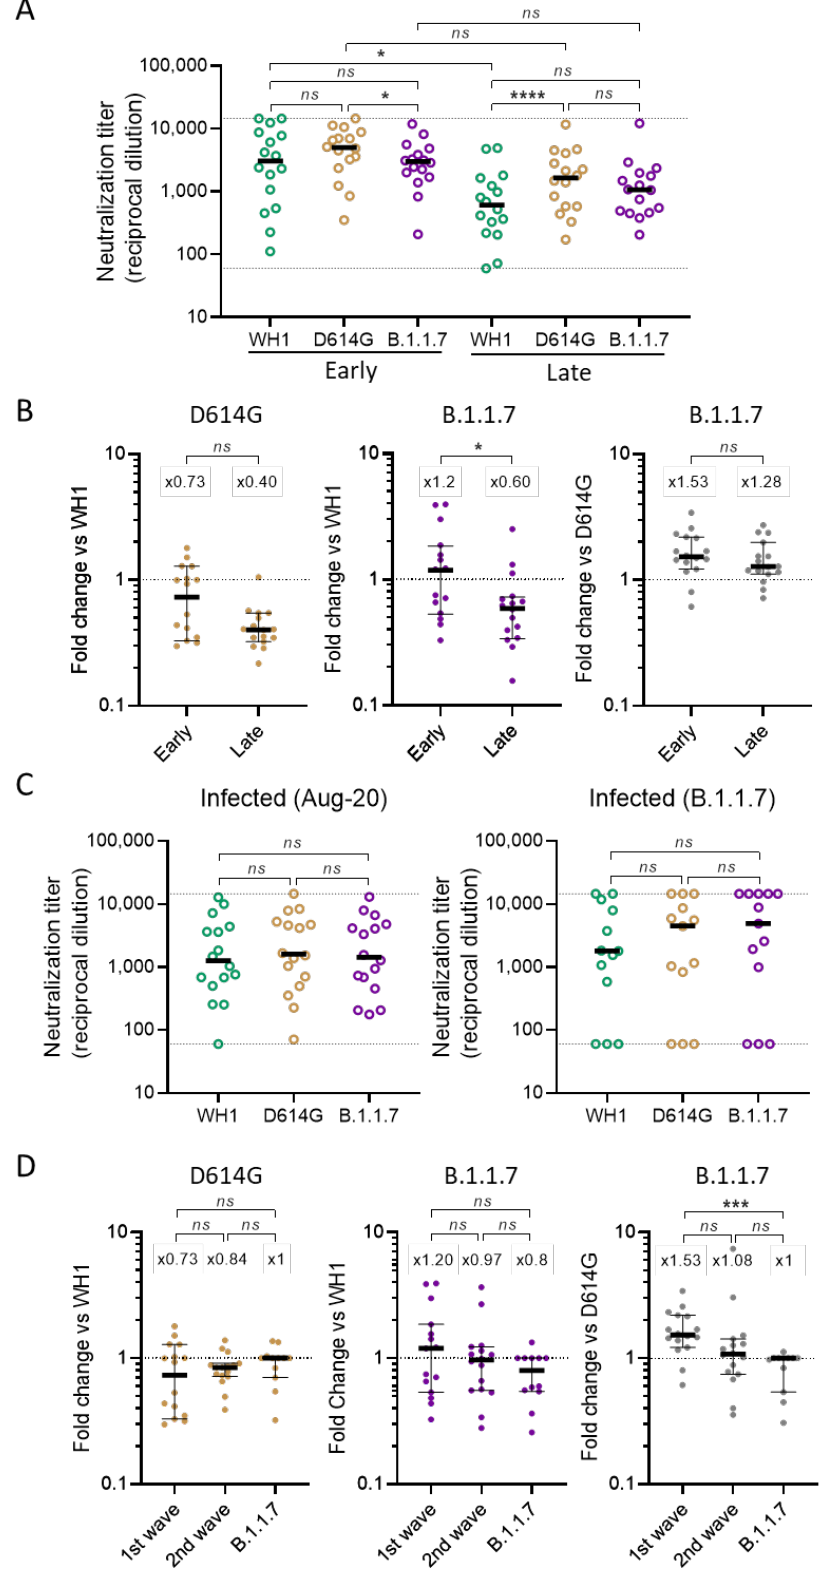
Figure 3. Subgroup analysis of neutralization titers in infected individuals. ( A , B ). Comparison of plasmas collected at 48 days (early sampling) and >6 month (late sampling) after infection